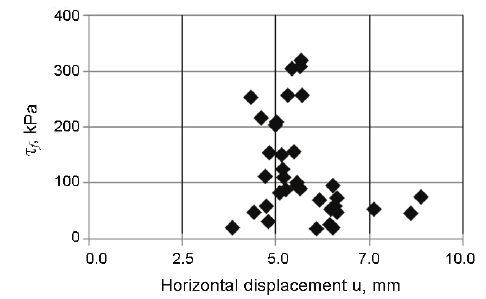
Fig. 5. Maximum shear stress versus horizontal displacement